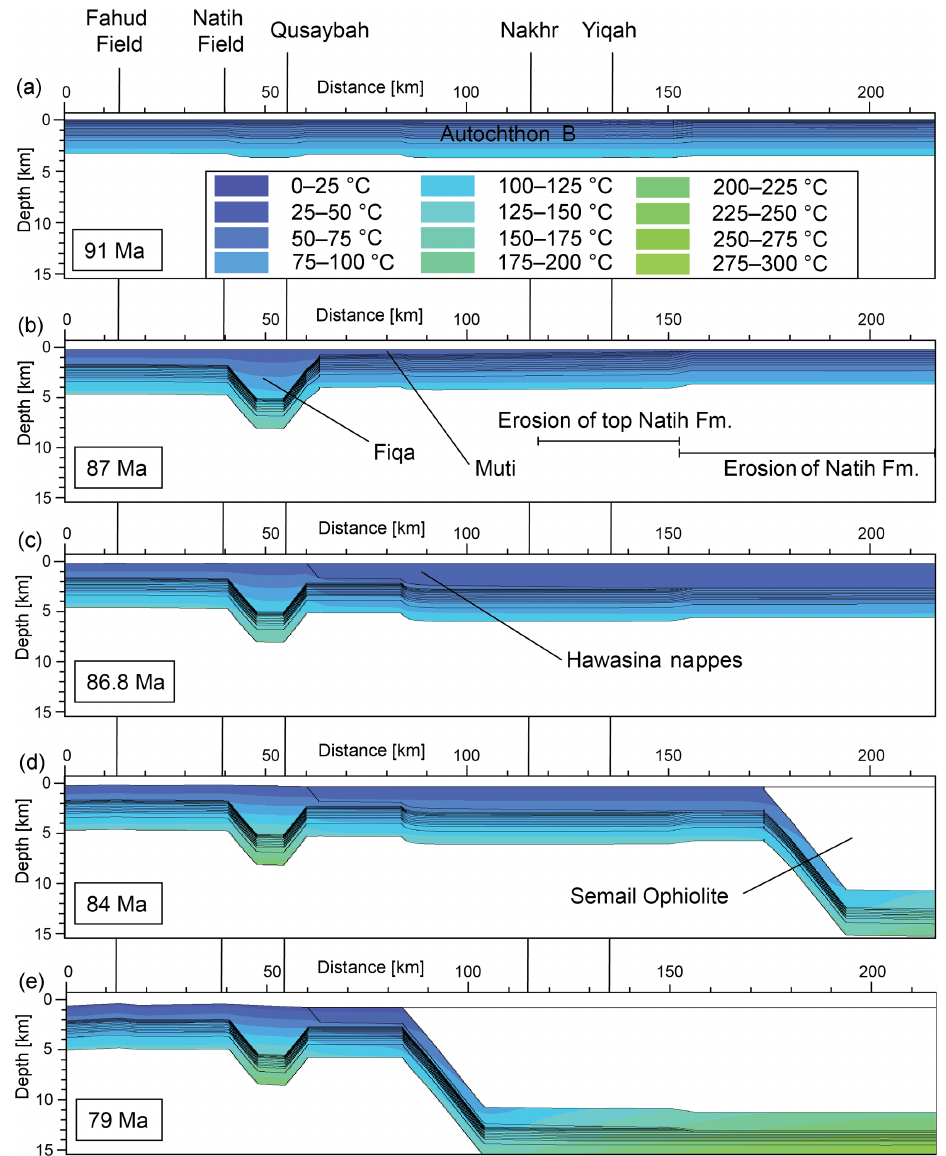
Figure 7. Modeling results: temperature distribution and temporal evolution along the transect of Fig. 6. Highlighted with vertical lines in the background are the locations of present-day oil fields and sampled valley